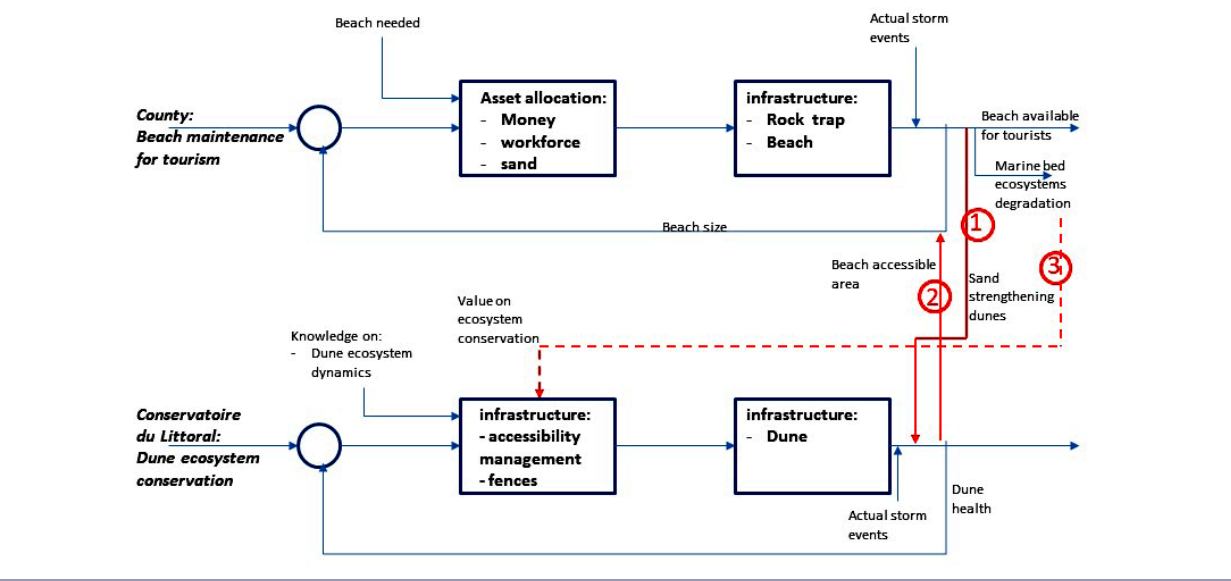
Fig. 5 . Vulnerability transfers observed in beach maintenance in